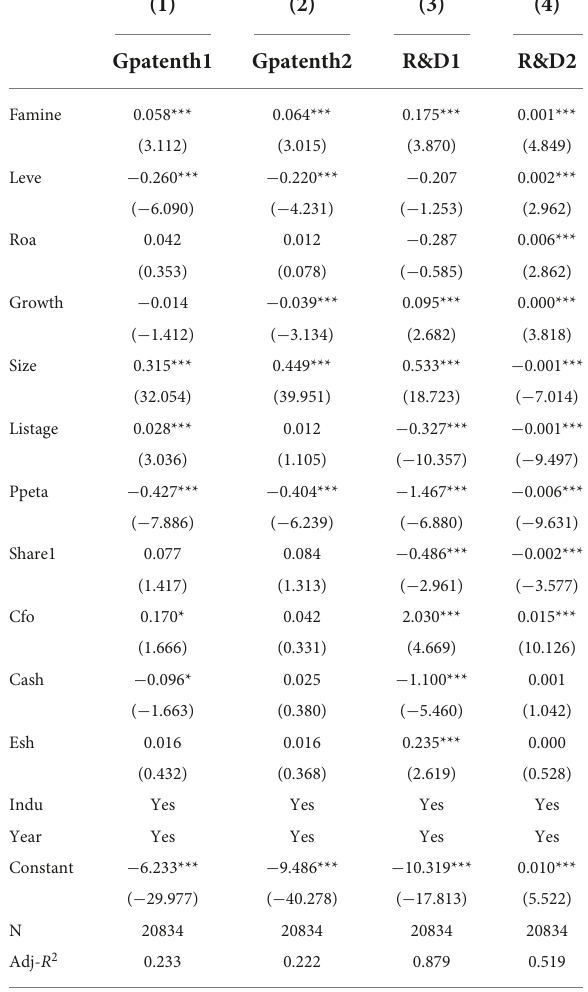
TABLE 9 Alternative measures of